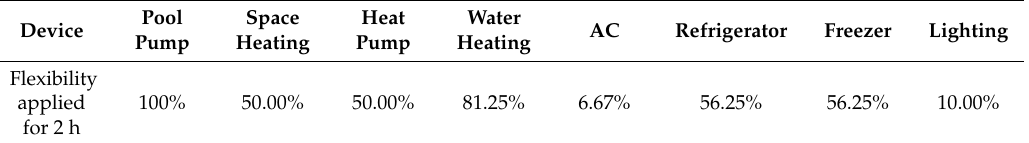
Table 3. Flexibility percentage applied to each appliance adjusted to a 2 h period.